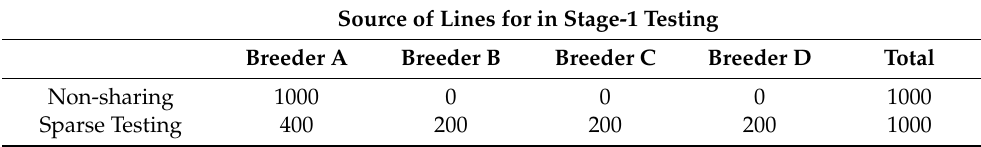
Table 8. The number of stage-1 lines tested by breeder A from each of four programs (A, B, C, and D) under a traditional non-sharing scheme and one possible sparse testing scheme used by a